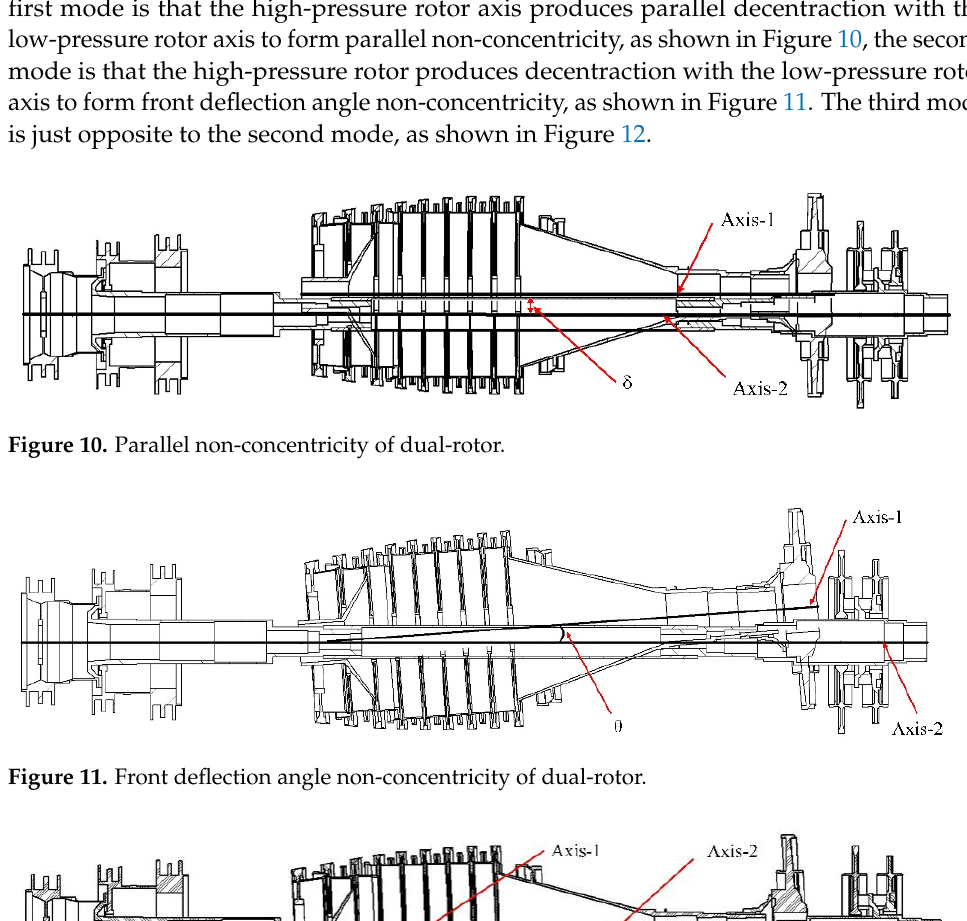
Figure 11. Front deflection angle non-concentricity of dual-rotor.